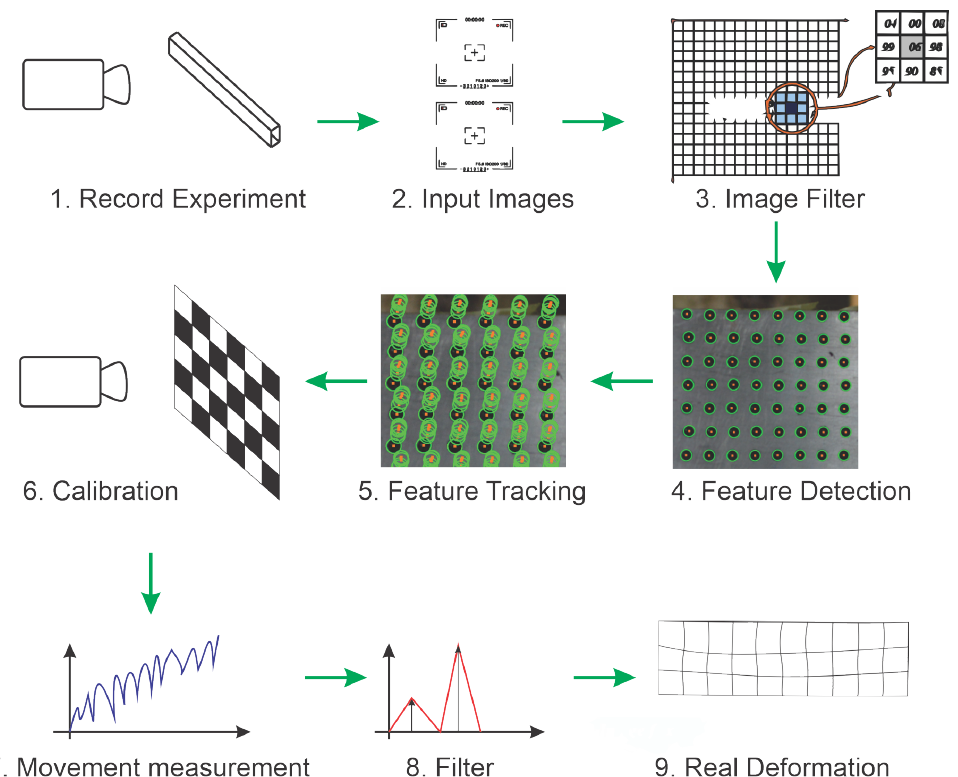
Figure 1. Representation of the proposed methodology for calculating displacement in